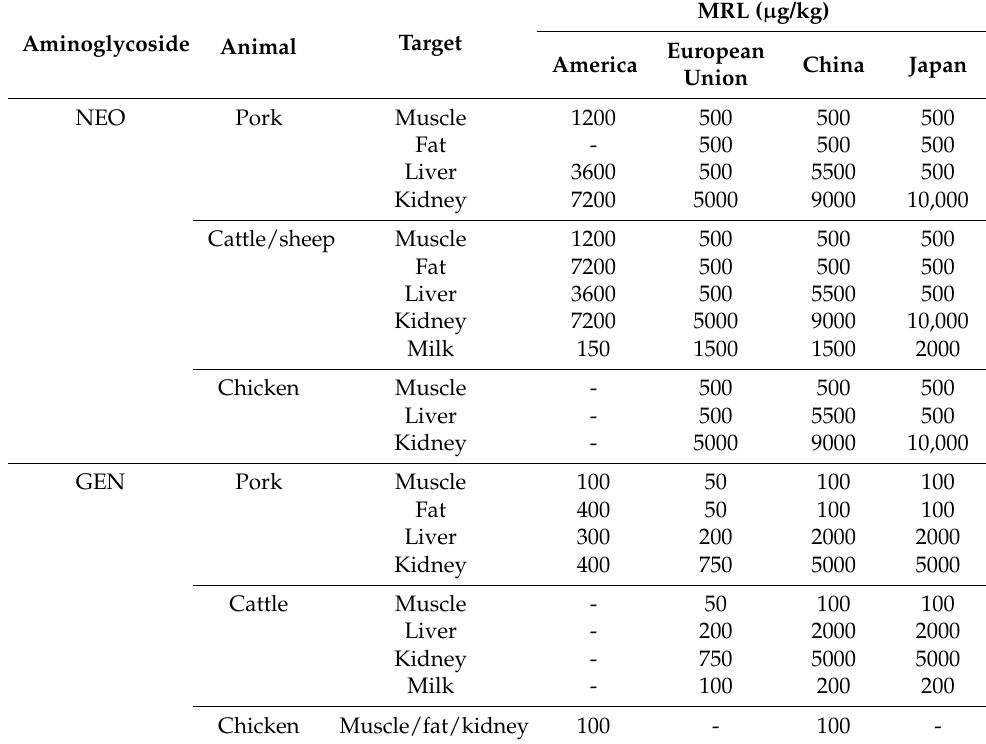
Table 1. Maximum residue limits (MRLs) in different